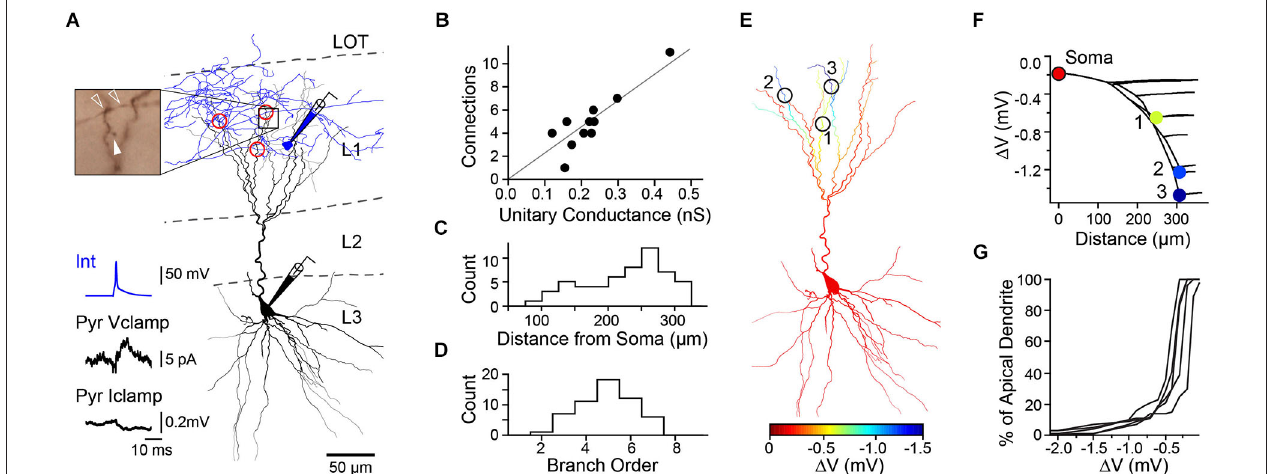
between number of putative connections and measured unitary conductance. Line, linear fit, r 2 = 0.79. (C) Location of synaptic contacts relative to PC soma. (D) Branch order of PC dendrites receiving synaptic contacts. (E) Simulated spatial profile of hyperpolarization from resting membrane potential ( ∆ V) for the PC recorded in (A) . (F) Plot of hyperpolarization vs. distance from soma (0 µ m) for all regions of apical dendrite with numbered synaptic contacts corresponding to sites in (E) . Red circle at distance = 0 represents the voltage at the soma. (G) Cumulative distribution of predicted dendritic hyperpolarization for reconstructed L1 INT-L3 PC pairs ( n = 5 cells, 5 slices, 5